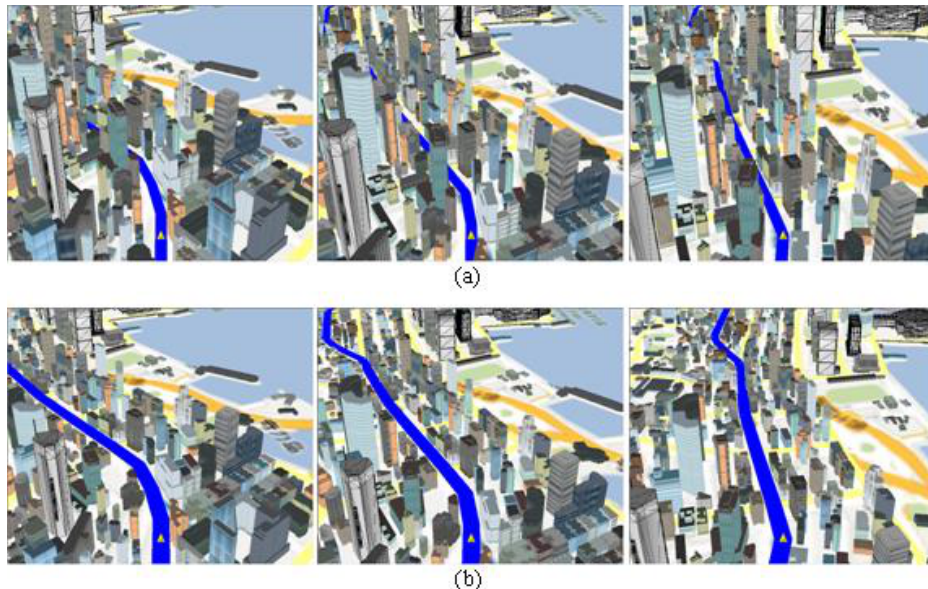
Figure 1. Animation snapshots in navigating Hong Kong city. ( a ) Ordinary perspective view. Corresponding occlusion-free view with spatial-temporal coherence. The route (in blue) is occluded by surrounding buildings in ( a ) while it is clearly visible in ( b ).